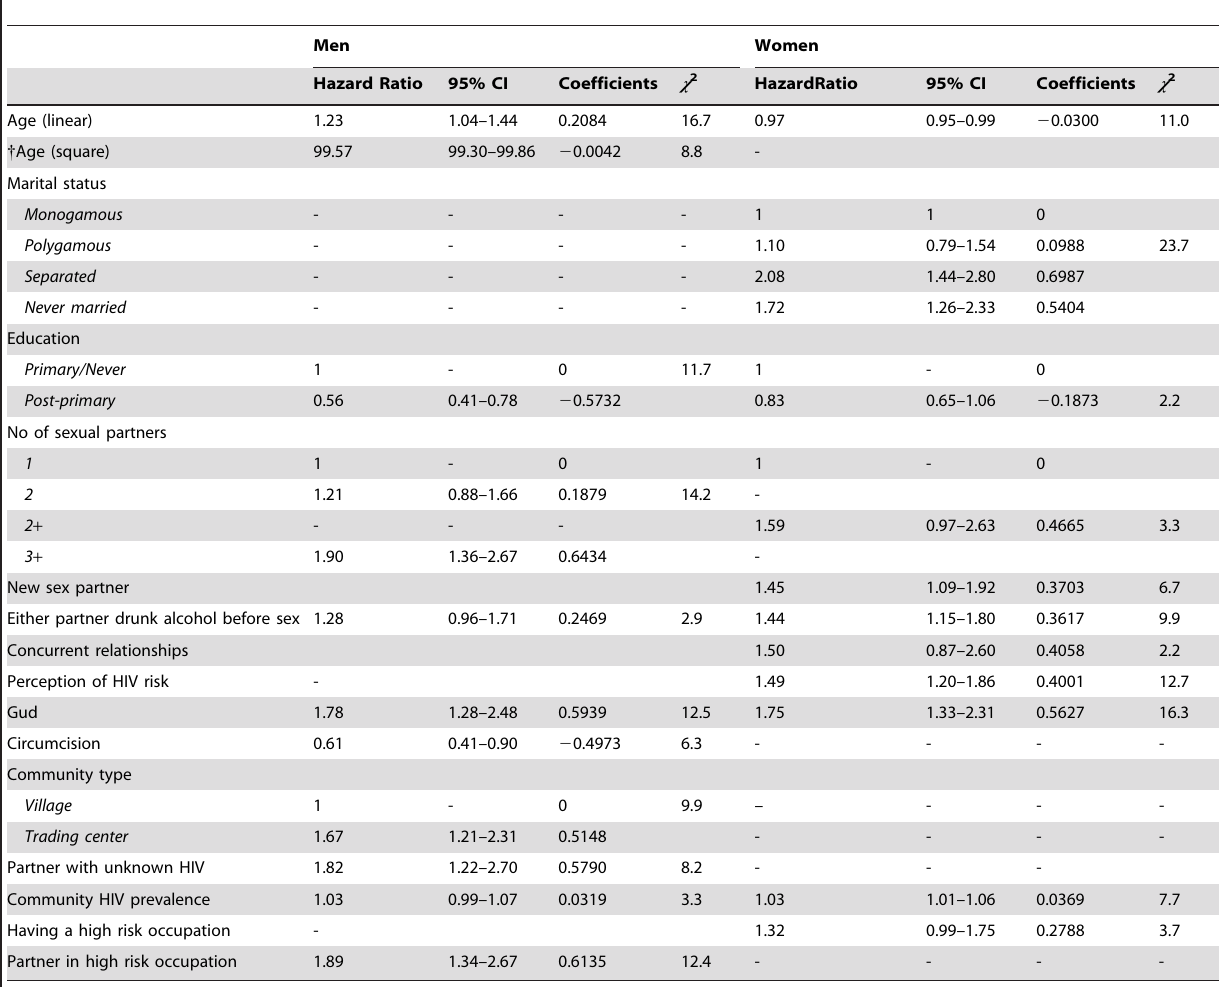
Table 4. Multivariable Associations between variables and HIV acquisition by Gender, Rakai, Uganda